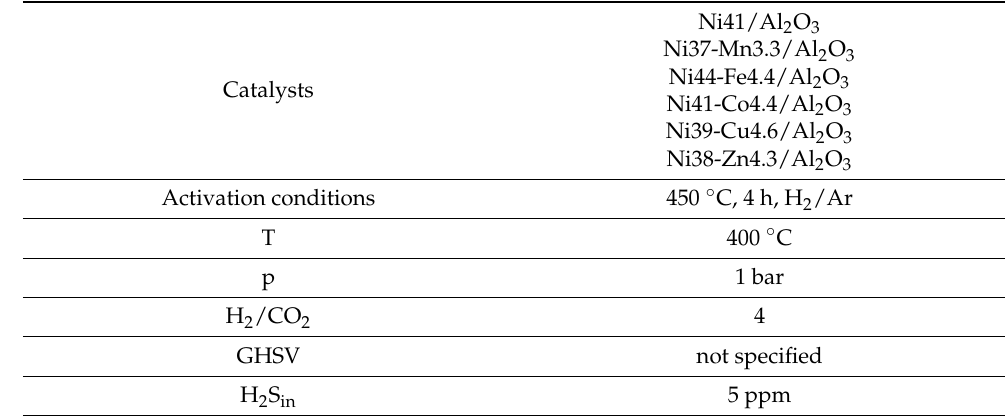
Table 16. Catalysts and reaction conditions for experiments on H 2 S influence on methanation with Ni/Al 2 O 3 and Mn, Fe, Co, Cu, and Zn promoter